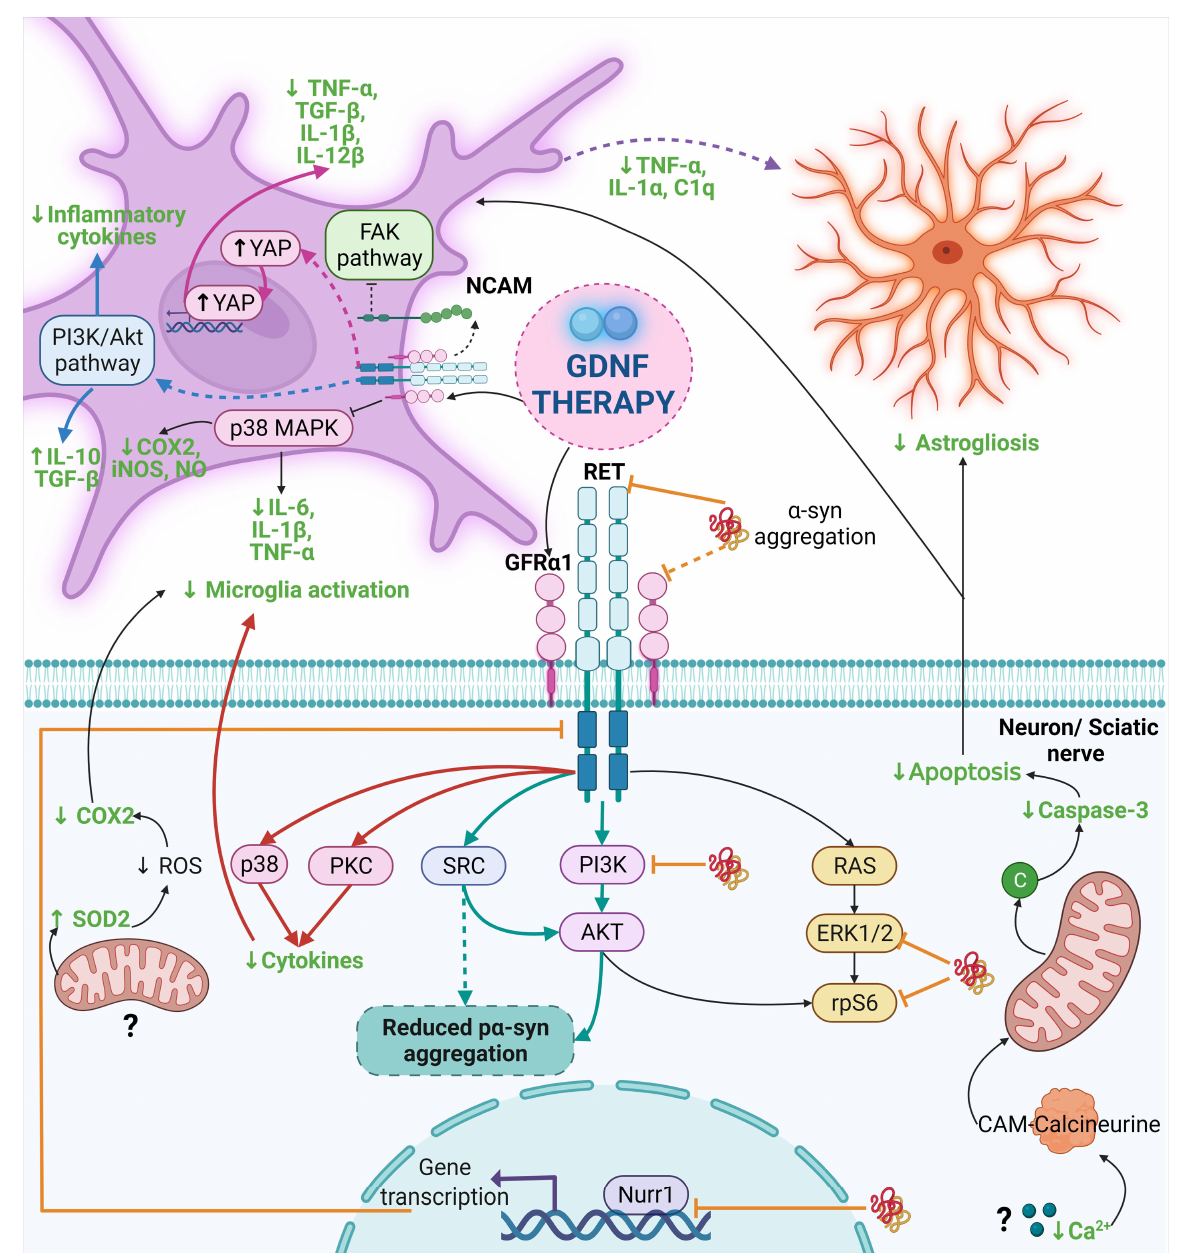
Figure 3. The anti- α -syn and anti-inflammatory effect of GDNF in PD and other diseases. Dash lines indicate the proposed mechanism by other authors and dash thick purple lines are the proposed mechanism in this review. The mechanism of the anti- α -syn and anti-inflammatory effect of GDNF points out with thick light blue lines and black lines in Parkinson’s disease, respectively. Thick orange lines indicate the interruption in the GDNF signaling caused by α -syn. The mechanism for the anti-inflammatory effect of GDNF is highlighted with thick pink lines, thick blue lines, and thick red lines for Alzheimer’s disease, neurological diseases, and neuropathic pain, respectively. The final anti-inflammatory effect of GDNF is in a bold green letter. Abbreviations: α -syn, α -synuclein; C1q, complement component 1q; CAM, Calmodulin; COX, cyclooxygenase; FAK, Focal adhesion kinase; GDNF, Glial cell-derived neurotrophic factor; GFR α 1, GDNF family receptor α 1; IL, interleukin; iNOS, Inducible nitric oxide synthase; NCAM, neural cell adhesion molecule; NO, Nitric oxide; PI3K, phosphoinositide 3-kinase; PKC, Protein kinase C; RET, Receptor tyrosine kinase; ROS, reactive oxygen species; SOD2, Superoxide dismutase-2; SRC; Proto-oncogene tyrosine-protein kinase Src; TGF- β , Transforming growth factor-beta; TNF- α , tumor necrosis factor-alpha; YAP, Yes-associated protein. Created with BioRender.com.